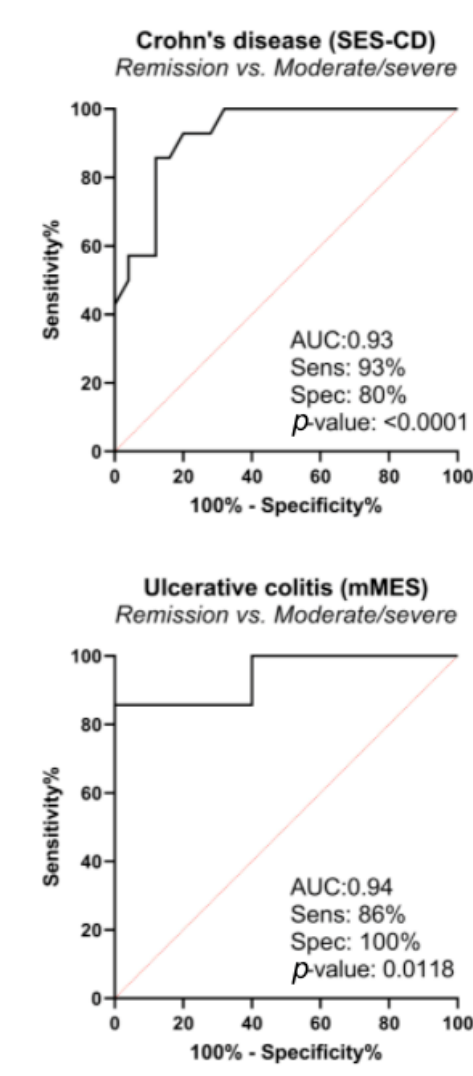
Figure 1. Diagnostic power of C4M, C3M/PRO-C3 biomarkers in combination by receiver operating characteristic curve (ROC curve), based on logistic regression model; correction for the following confounding factors was made: in Crohn’s disease for age, gender, body mass index (BMI), smoking, prior surgery, biological therapy, Montreal classification, and in ulcerative colitis for age, gender, BMI, biological therapy, Montreal classification.